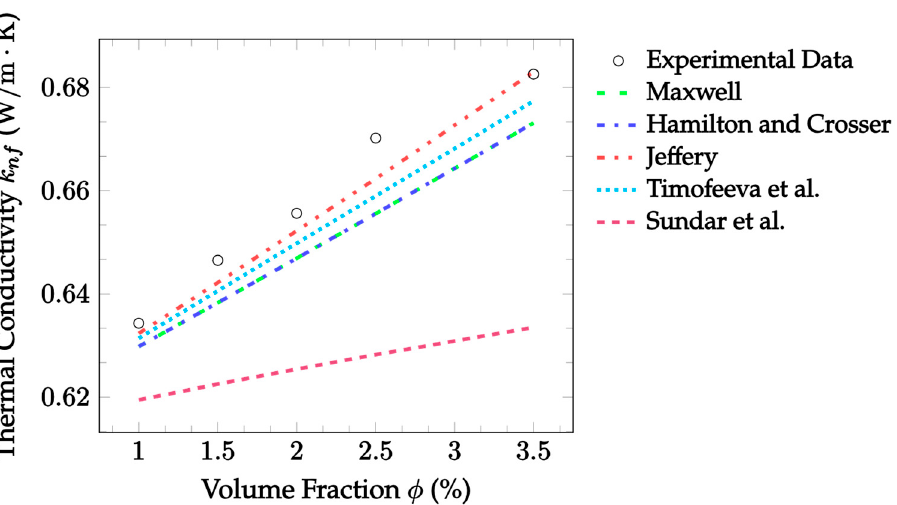
Figure 2. EMT model predictions compared with experimental data for spherical CuO–water nanofluid at 300 K with volume fractions between 1.0–3.5%: Experimental Data [59], Maxwell [14], Hamilton and Crosser [15], Jeffery [16], Timofeeva et al. [17], Sundar et al. [18].